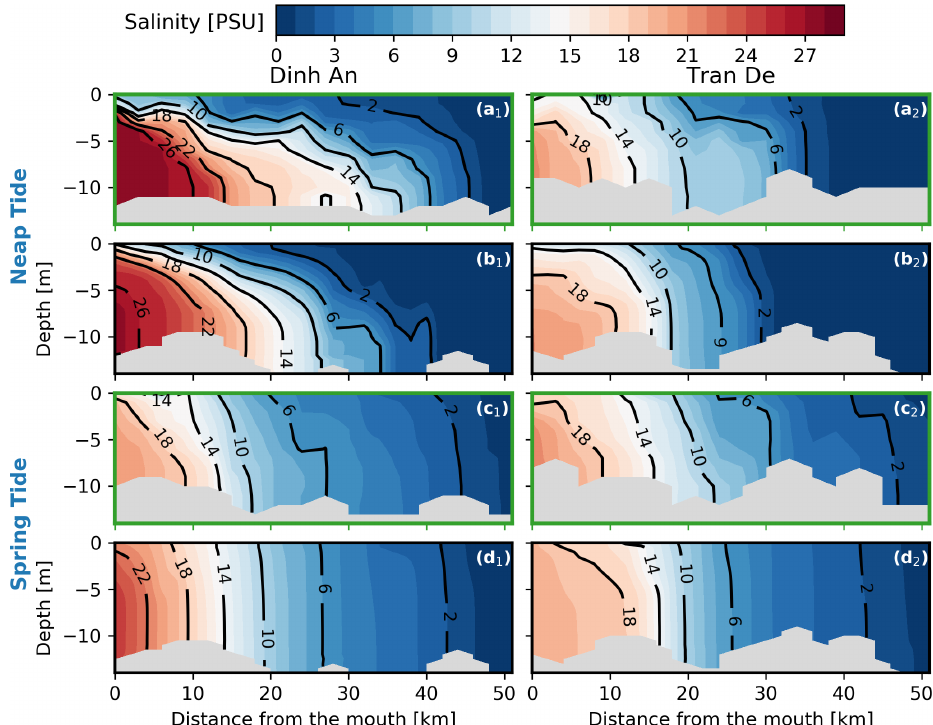
Figure 5. Measured ( a and c with green frames) vs. modelled ( b and d ) HWS salinity structure along two distributary channels of the Hau River during neap tide ( a and b , 15 April) vs. spring tide ( c and d , 9 April) for the year 2016.